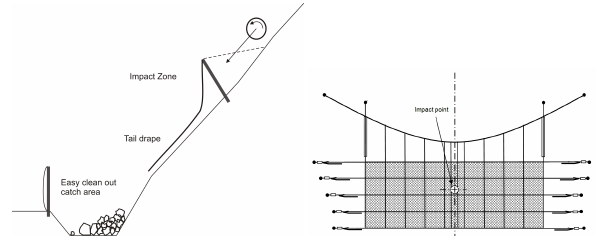
Fig. 19. Principle mode of operation for rockfall attenuating system (left, Glover et al., 2010) and system sketch for typical hanger net system (right).